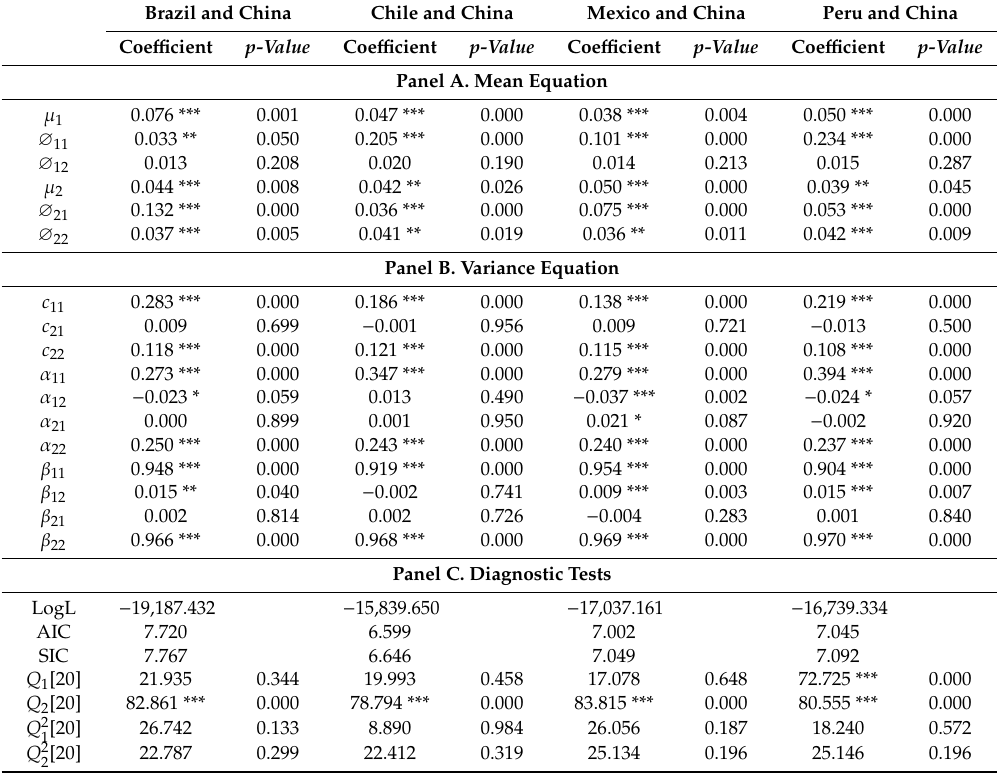
Table 6. Estimates of BEKK-GARCH for the China and Latin American stock markets during the full sample